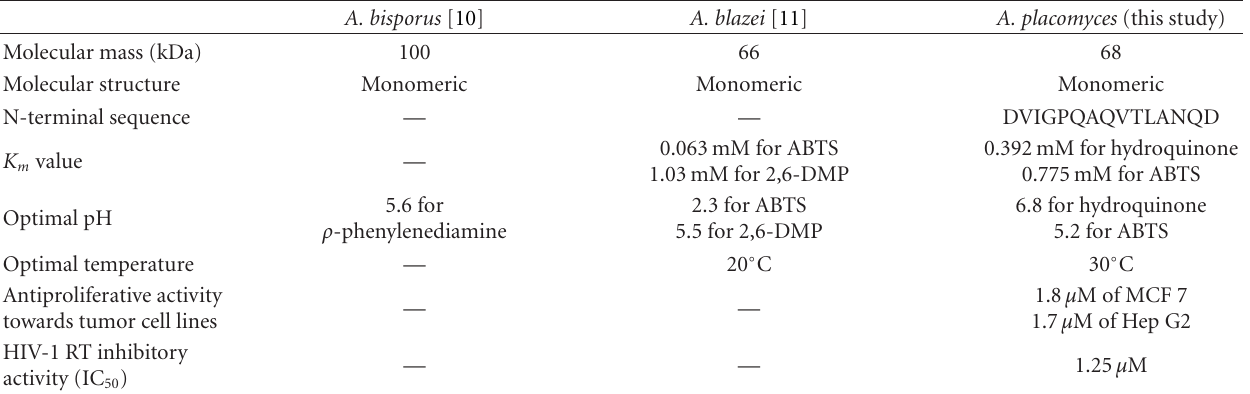
Table 4: Characteristic comparison of laccases from A. bisporus [10], A. blazei [11], and A. placomyces (this